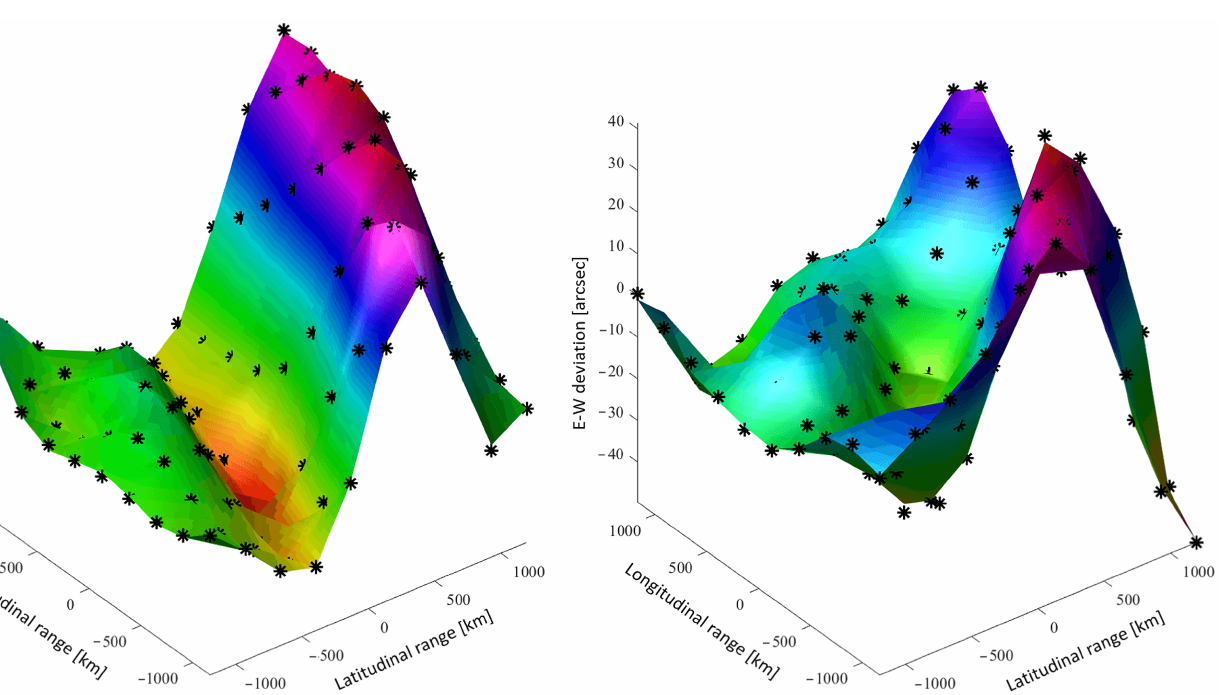
Figure 8. East–West and North–South geoid deviation (Himalaya